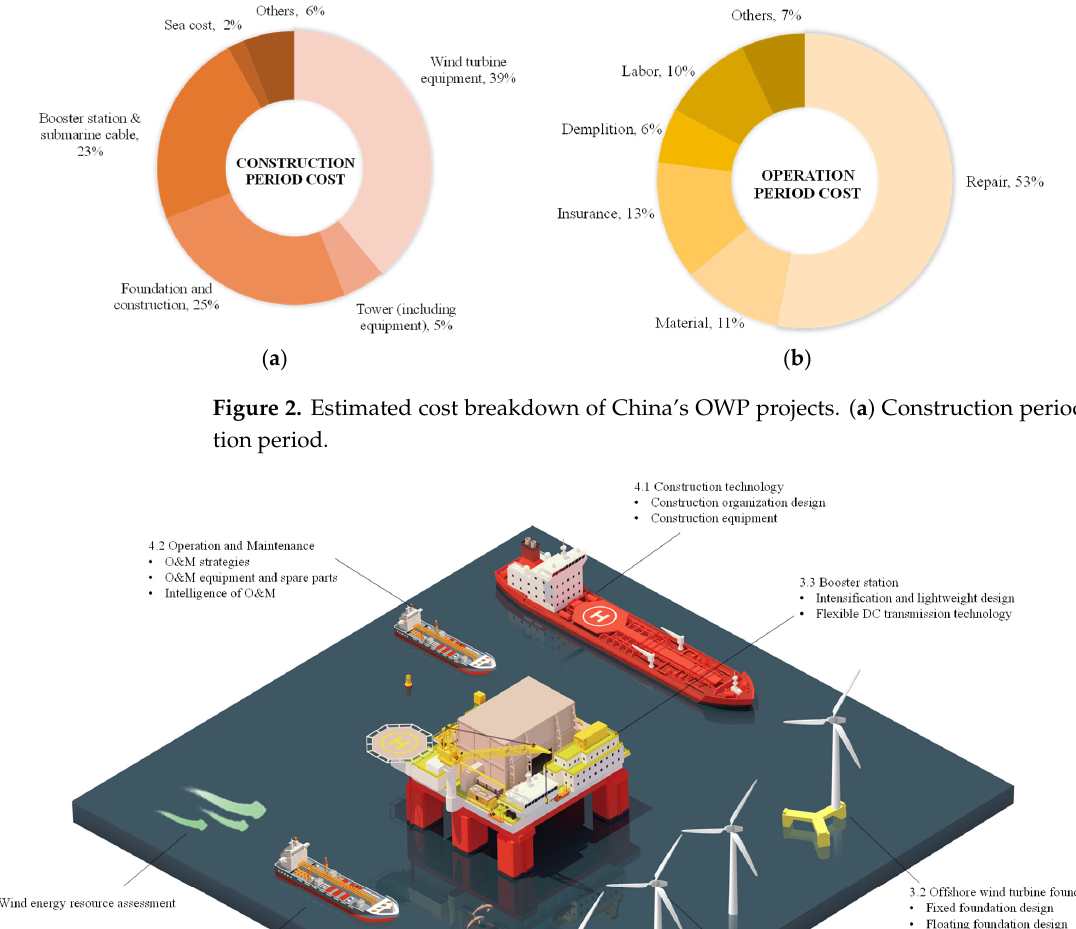
Figure 2. Estimated cost breakdown of China’s OWP projects. ( a ) Construction period; ( b ) operation period.